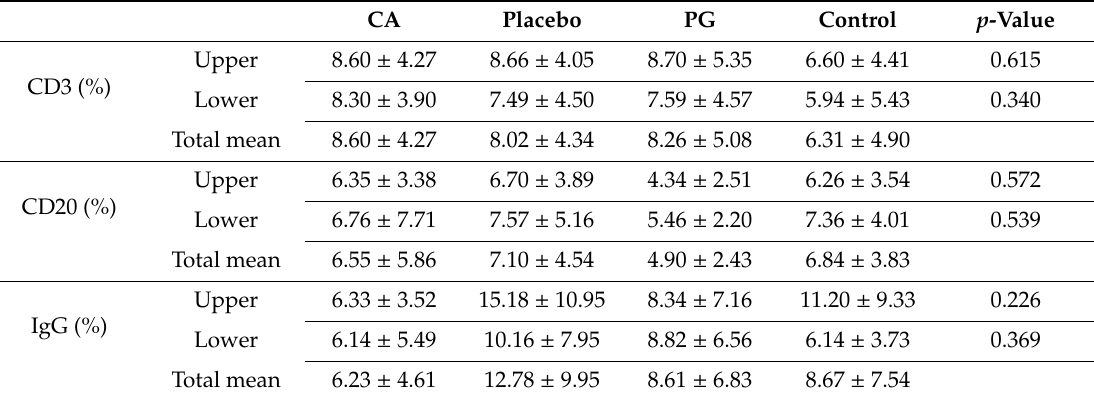
Table 2. IHC cell marker